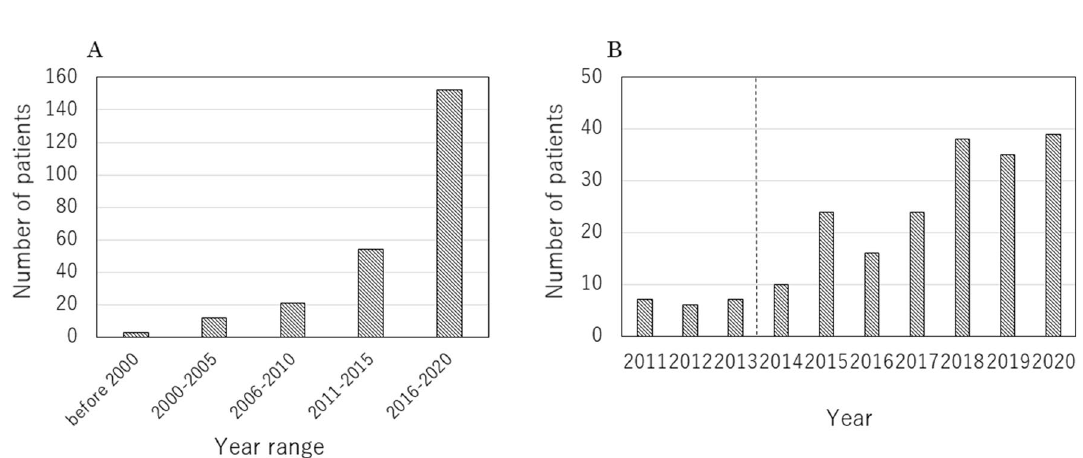
Figure 4. Number of NF1 patients by year. ( A ) year range separated by 5 years. ( B ) recent years. The dotted line indicates the time when the NF1 in-hospital medical care network was